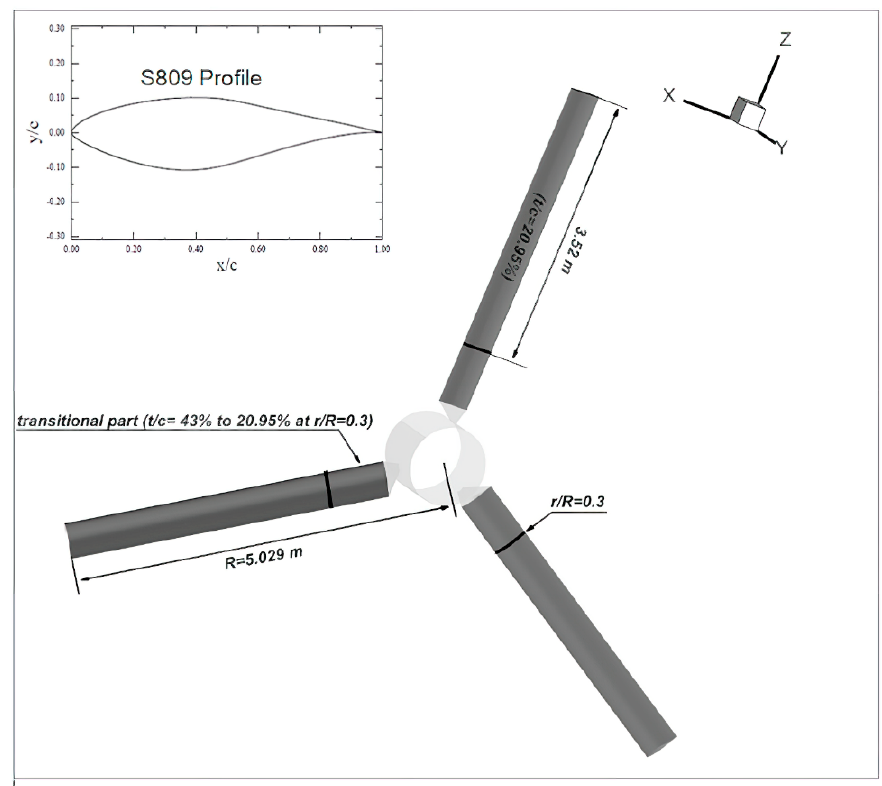
Figure 1. NREL phase ii rotor.